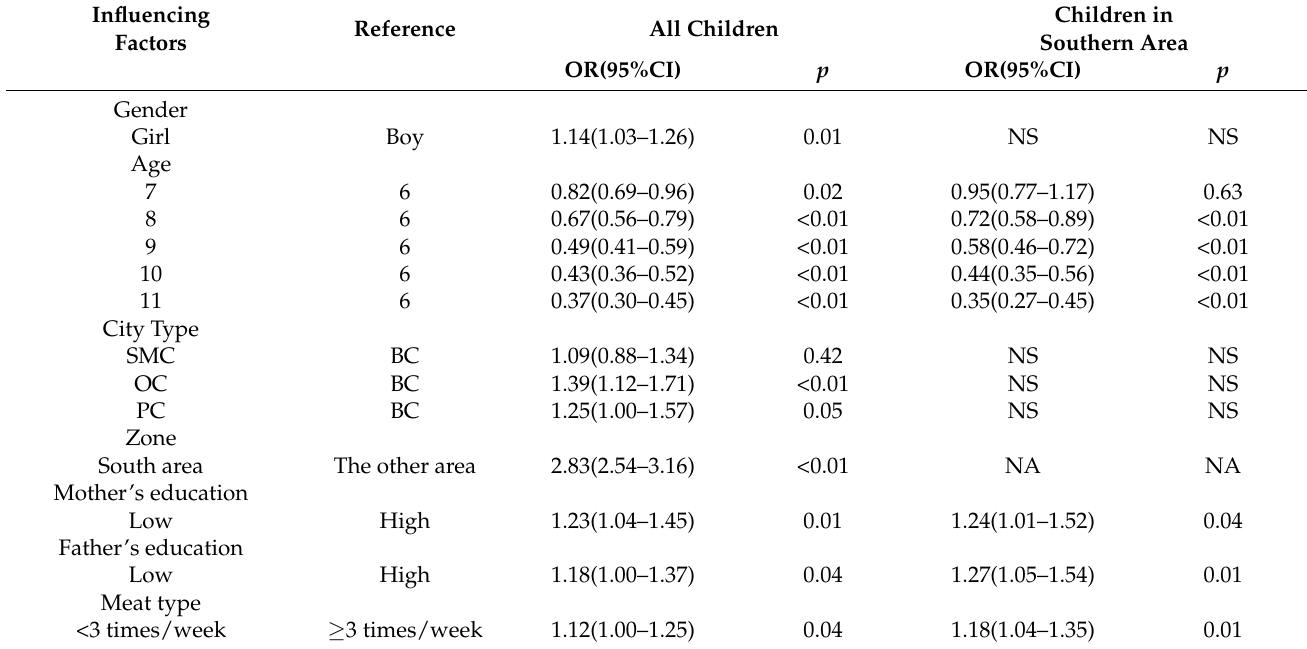
Table 2. Factors associated with children anemia based on multivariate logistic regression